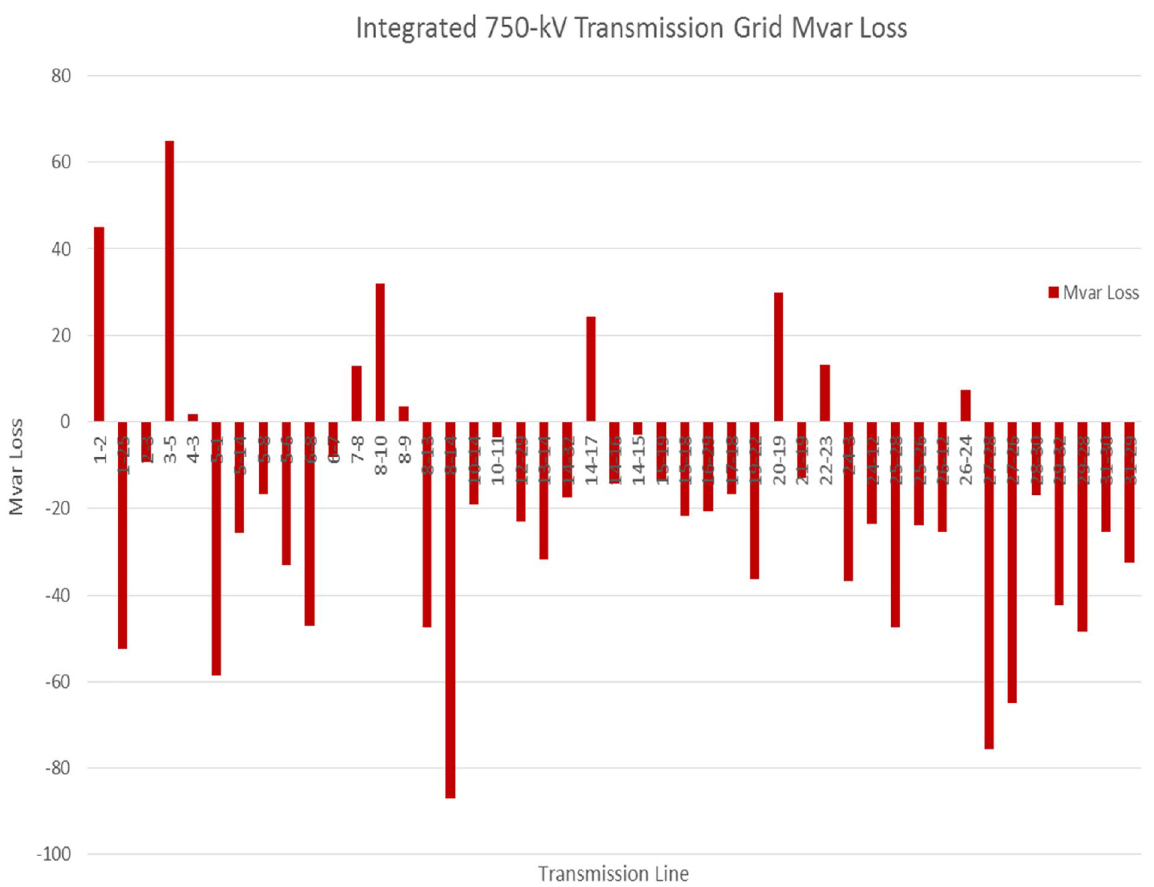
Fig. 12 Reactive power loss of integrated 750-kV super grid